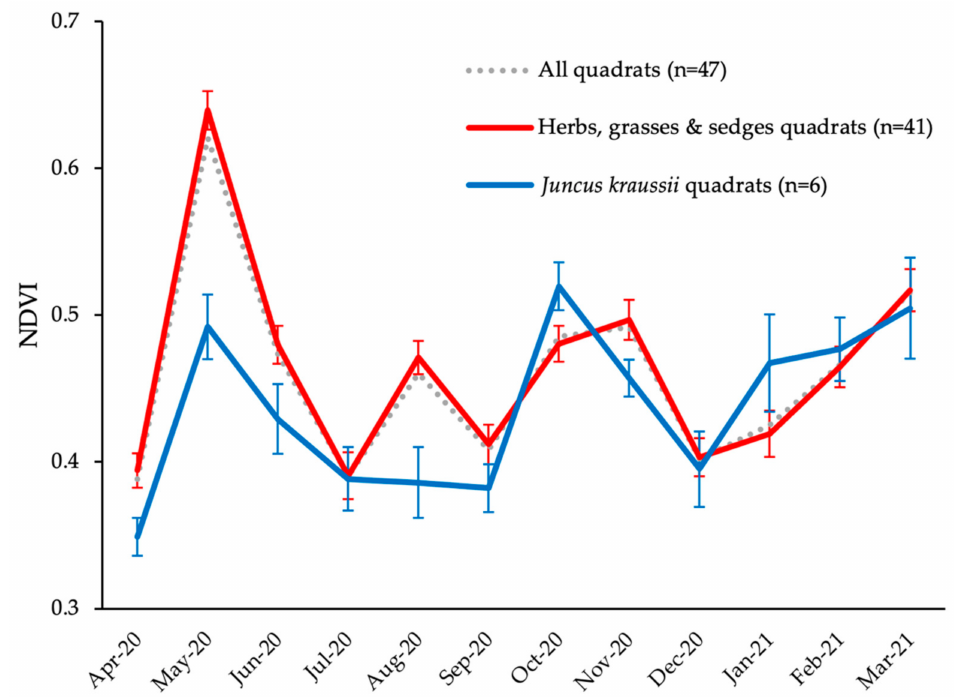
Figure 7. Temporal variation in mean NDVI extracted at each quadrat location from the 12 Plan- etScope images (April 2020 to March 2021). Error bars show ± 1 standard error.